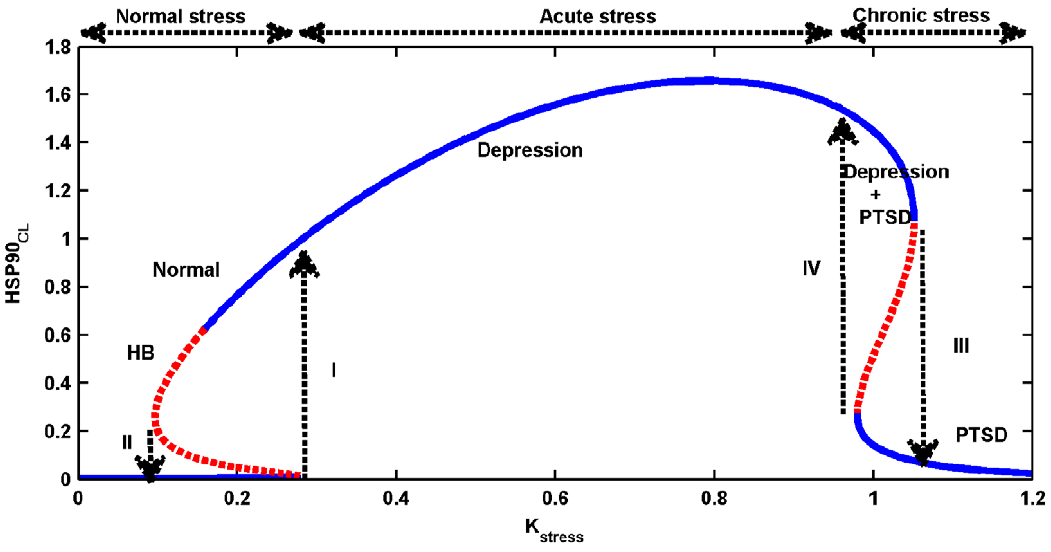
Figure 7. Occurrence of mushroom dynamics in the full ordinary differential equation (ODE) model with k stress as the bifurcation parameter. Two bistable forms, S-shaped (on the left, normal stress), and Z-shaped (on the right, chronic stress) are present together, giving rise to a mushroom when the bifurcation parameter k stress is varied. During normal stress, HSP90 CL increases and crosses the threshold I, to transit to another stable steady state with a high concentration. When the stress level decreases, HSP90 CL concentration also decreases gradually from a high to a low concentration level by crossing the threshold II, and retaining the normal homeostatic conditions. This happens in the S-shaped bistable form. In contrast, during acute stress, HSP90 CL crosses the threshold I and correspondingly it increases; this is attributed to depression. Further increase in acute stress results in the moderate increase of HSP90 CL , wherein post-traumatic stress disorder (PTSD) develops along with depression. During chronic stress, HSP90 CL abruptly drops to a very low level by crossing the threshold III. This is attributed to PTSD, where high stress level results in a very low concentration of HSP90 CL . This event occurs in the Z-shaped bistable part of the mushroom dynamics. If the stress level decreases from a very high value, i.e, k stress ~ 1 , HSP90 CL slowly increases from a very low concentration, but once it crosses the threshold IV, there is an abrupt jump in the concentration. The stable steady state is shown as a continuous blue line, whereas the unstable steady state is shown in dashed red lines.